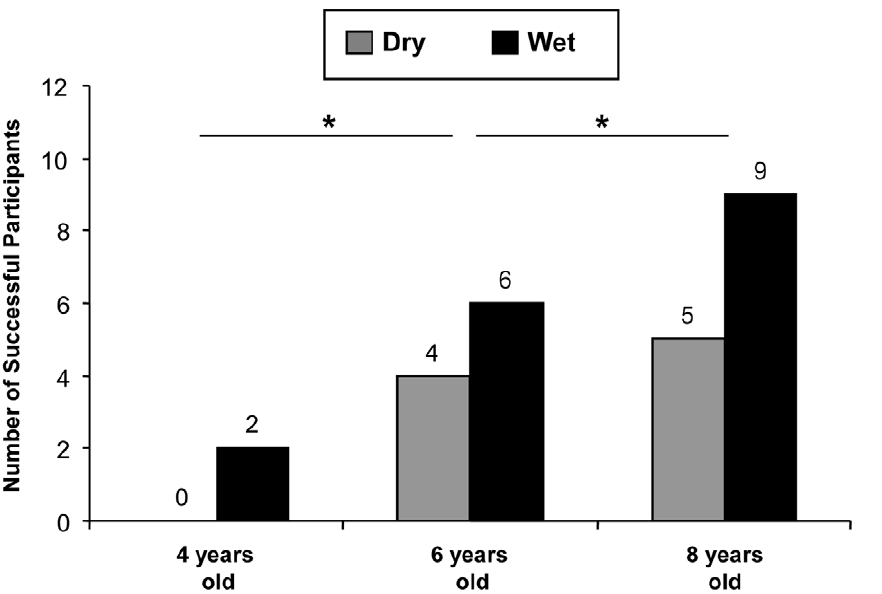
Figure 4. Number of successful children for each of the three age classes. Grey bars represent participants in the dry-condition group; black bars represent participants in the wet-condition group. * p , .05.